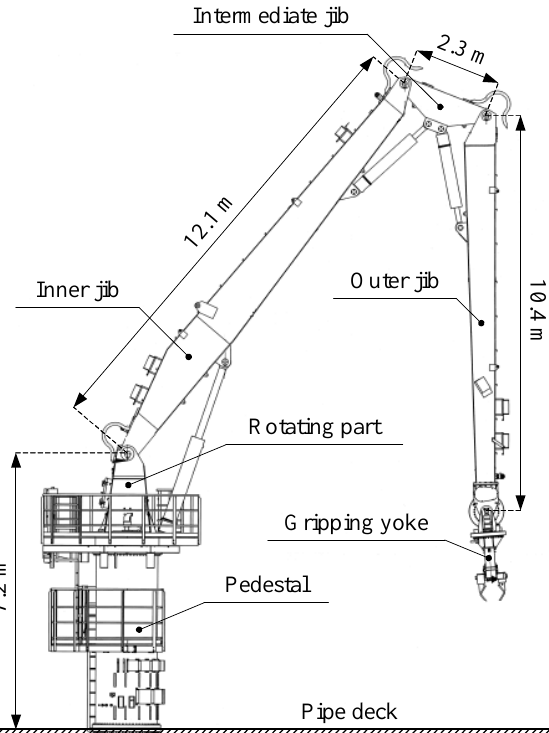
Figure 1: Main components of the mechanical